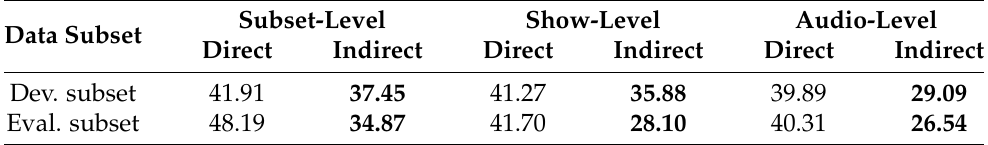
Table 2. Study of the impact of diarization on speaker attribution with oracle calibration. Experiments carried out with direct (without diarization) and indirect assignment (with diarization) systems. Three degrees of calibration generality are shown. AER (%) results for the Albayzin 2020 development and test subsets. Experiment corresponding to the open